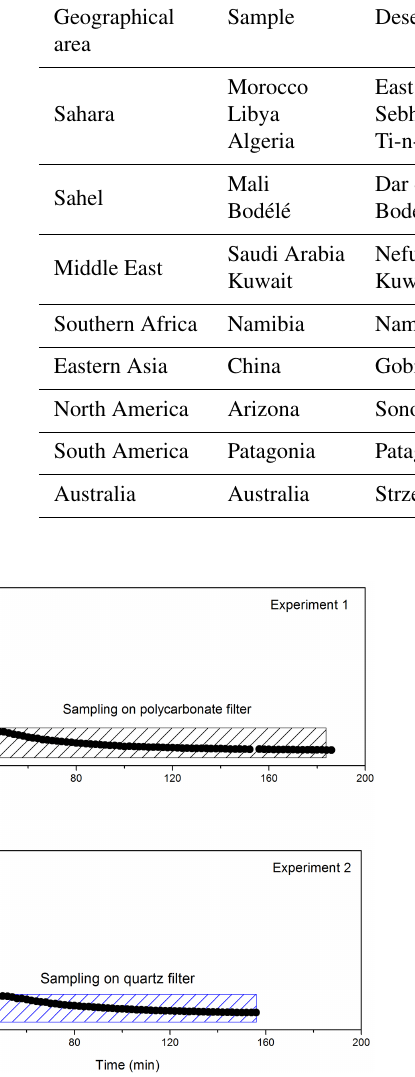
Figure 1. Time series of aerosol mass concentration in the chamber for two companion experiments (Libyan dust). Experiment 1 (top panel) was dedicated to the determination of the chemical compo- sition (including iron oxides) by sampling on polycarbonate filters. Experiment 2 (bottom panel) was dedicated to the determination of the absorption optical properties by sampling on quartz filters.